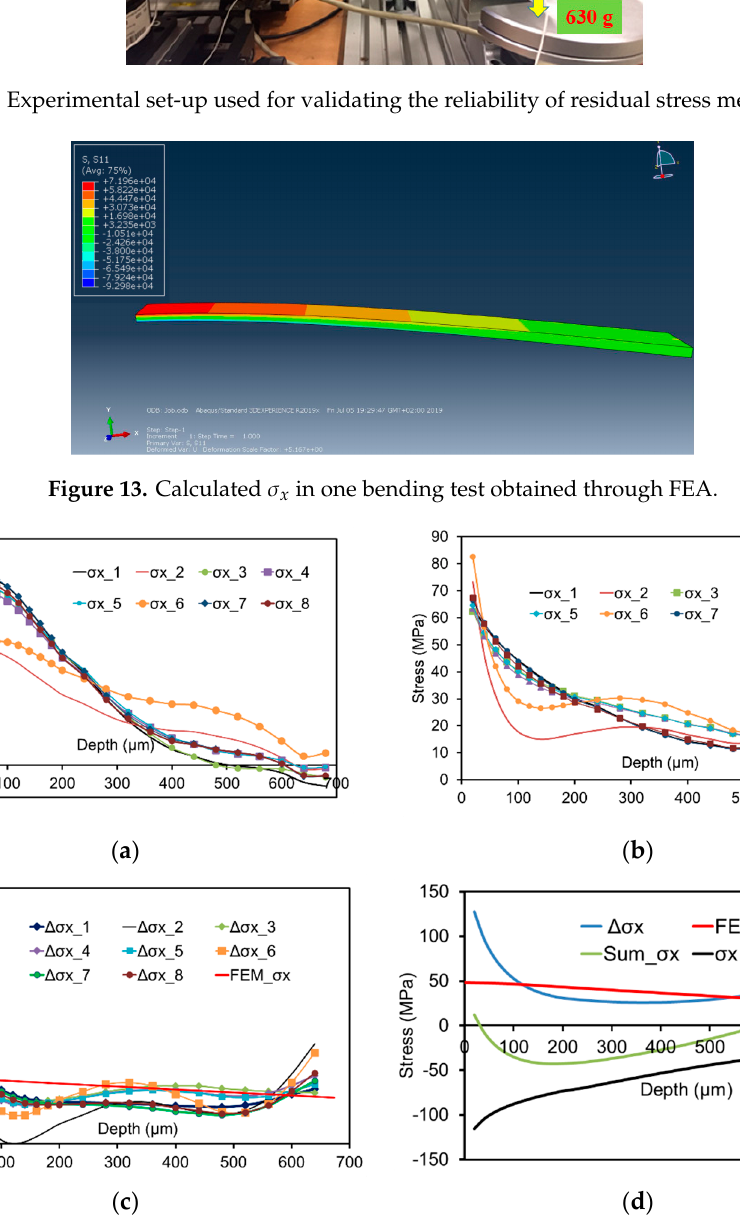
Figure 14. Experimentally determined residual stresses ( a ) σ x on the CFRP side without external loading, ( b ) σ x on the CFRP side with superimposed external loading, ( c ) reliability validation of the measured residual stress σ x on the CFRP side by FEA ( d ) reliability validation of the measured residual stress σ x on the metal side by FEA. See text for details.